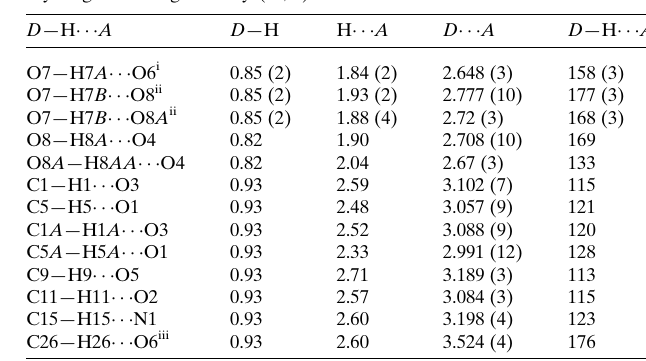
Table 1 Hydrogen-bond geometry (A˚ , (cid:3)